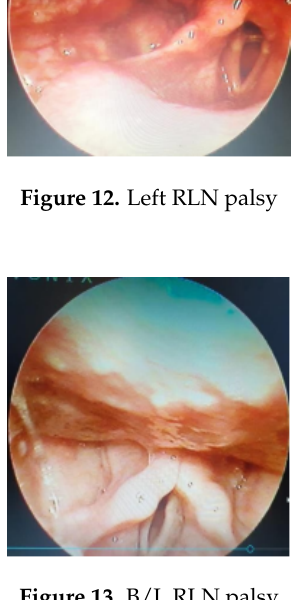
Figure 13. B/L RLN